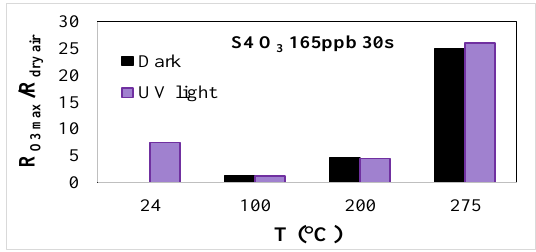
Figure 5. O 3 sensor responses of S4 (post-annealed at 300 °C) for working temperatures from 25 to 275 °C without and with UV